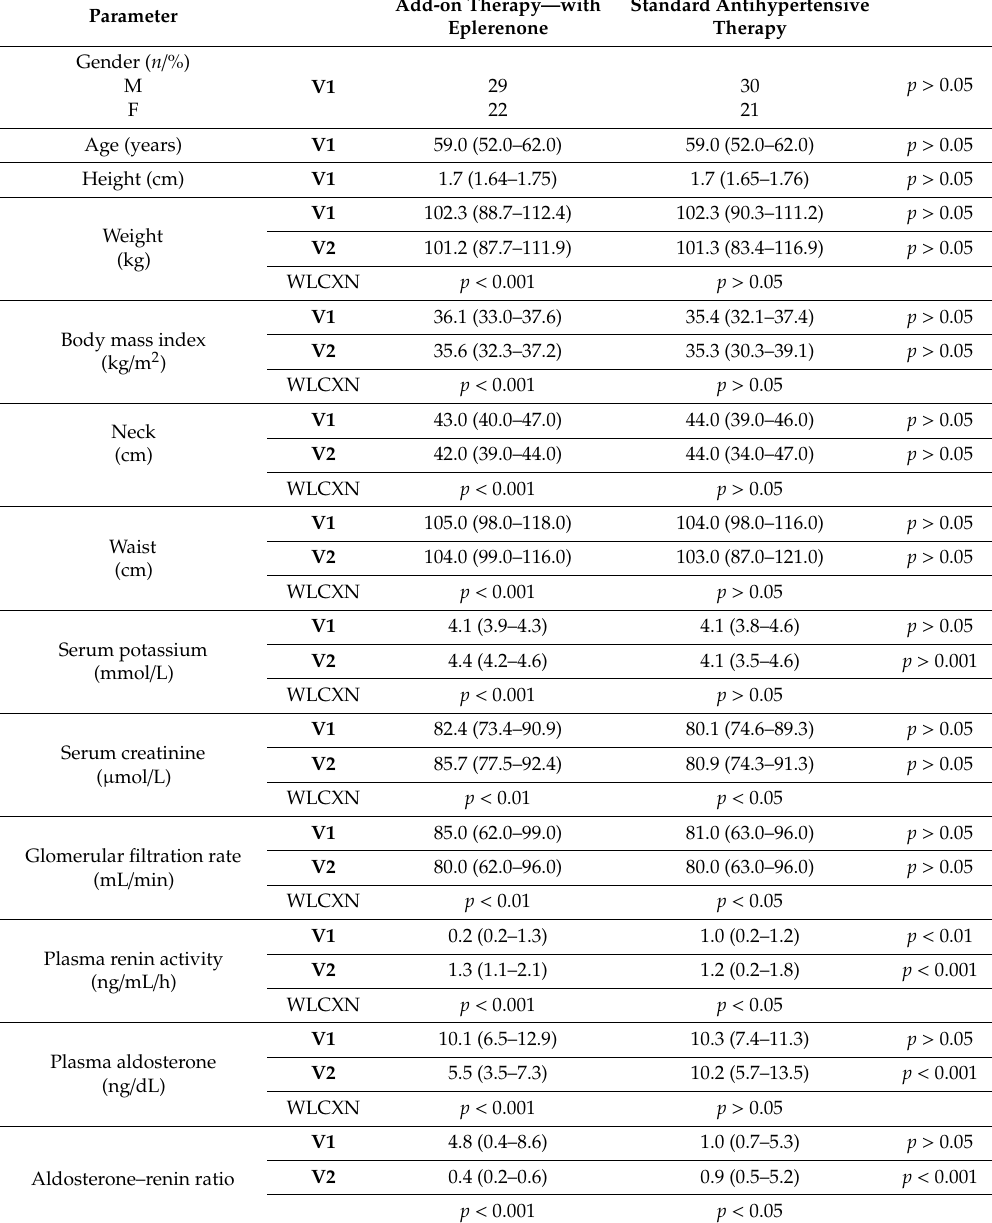
Table 1. Demographical characteristics, body composition, and renal parameters of patients assigned to add-on treatment with eplerenone (50 mg / day) and standard hypertensive treatment before (V1) and after 6 months (V2). All values are reported as median (interquartile range). The statistical comparison of parameters before (V1) and after treatment (V2) was conducted with Wilcoxon test (WLCXN) while the Eplerenone versus standard hypertensive treatment before comparison was conducted with Mann–Whitney U test (MW- U ) except Pearson’s chi-squared test ( χ 2 ) for gender. Add-on Therapy—with